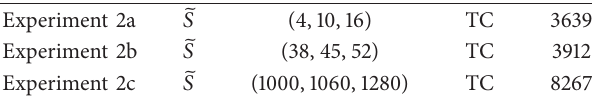
Table 4: Data for Experiments 2a, 2b, and